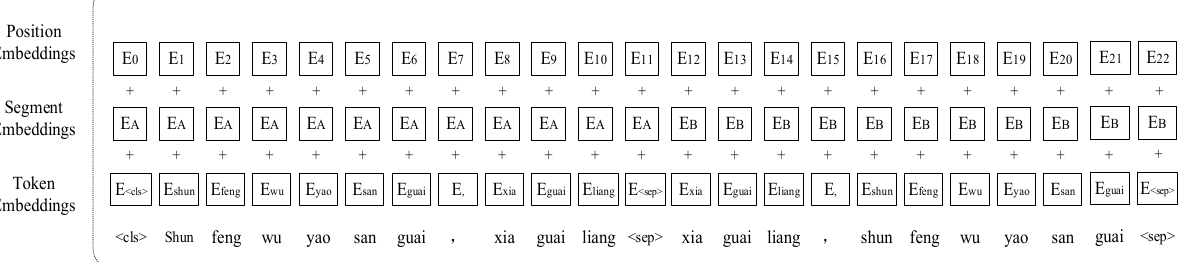
Figure 4. Comparison of MLM task structures with di ff erent strategies. The speci fi c calculation formula is as follows: t